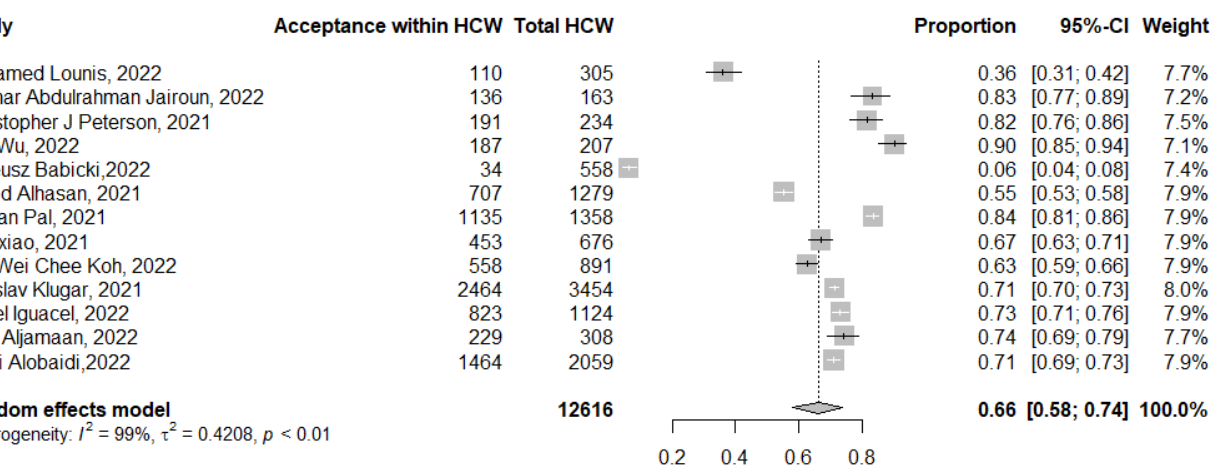
Figure 6. Acceptance of COVID-19 booster dose vaccination (actual and intentional) among healthcare workers (HCWs).